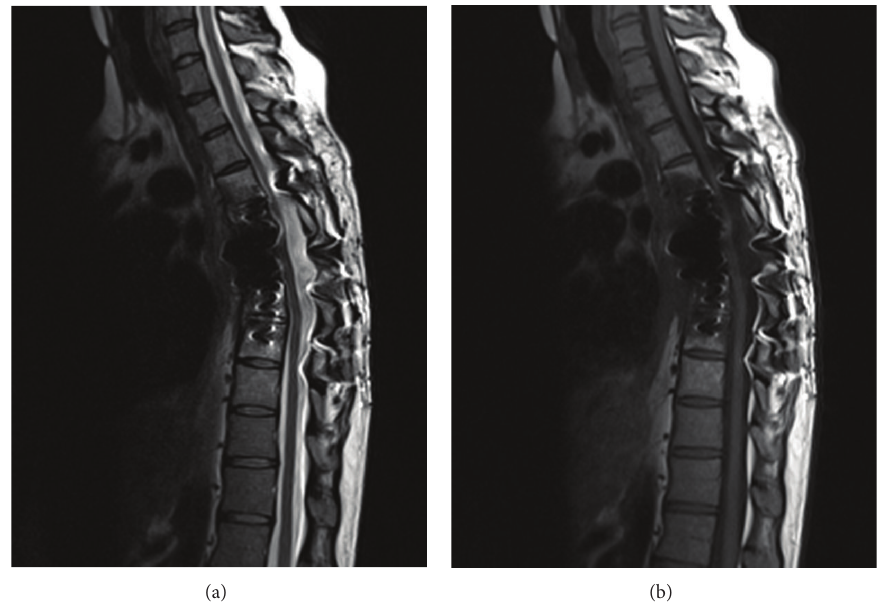
Figure 4: Sagittal T1 (a) and T2 (b) weighted images show postsurgical changes with no significant residual tumor 7 months after